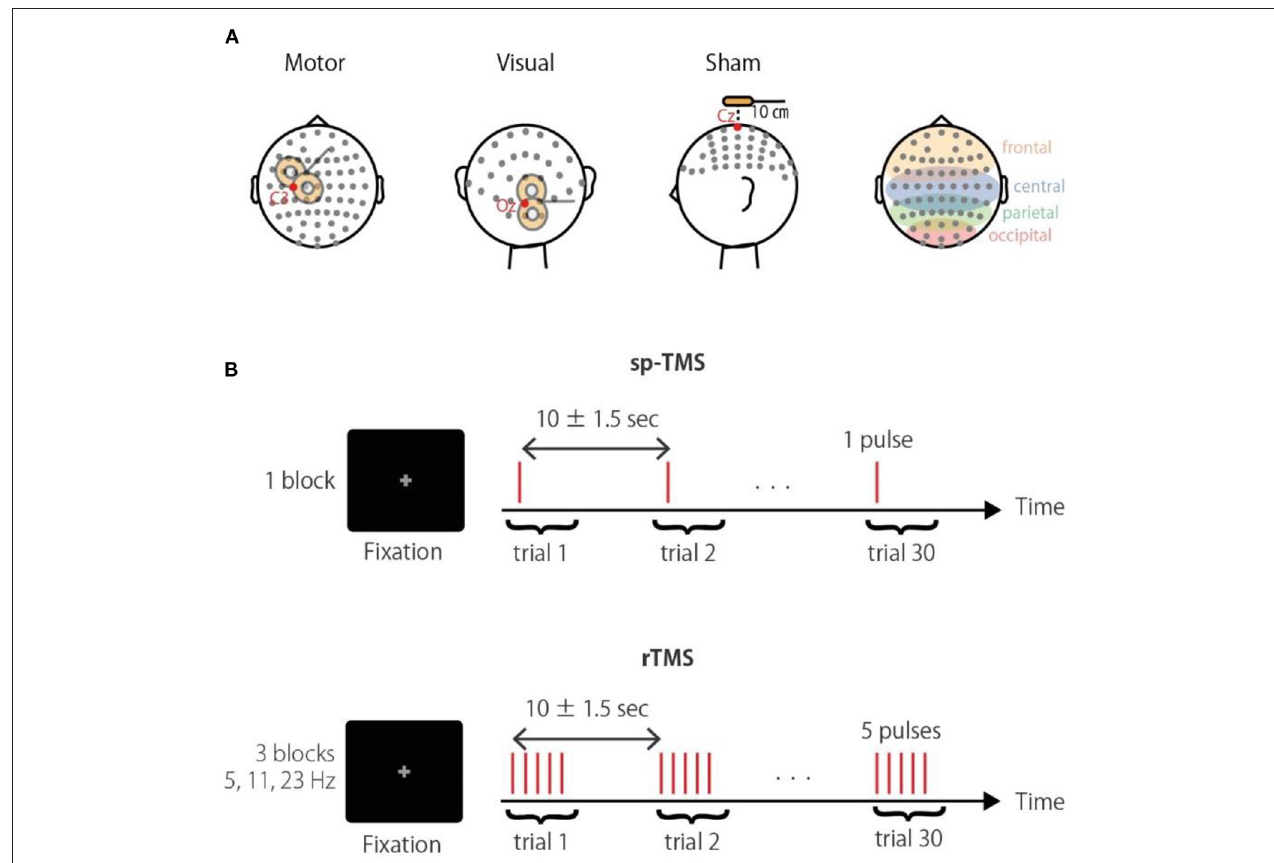
FIGURE 1 | Experimental paradigm. (A) Schematic illustration of the stimulation sites. Corresponding electrodes to the occipital, parietal, central, and frontal areas are highlighted in the right panel. (B) The TMS conditions were a single pulse (sp-TMS), and five pulses at 5, 11, or 23Hz (rTMS). The TMS conditions were provided in blocks with 30 repetitions. Participants had to fixate a central cross during